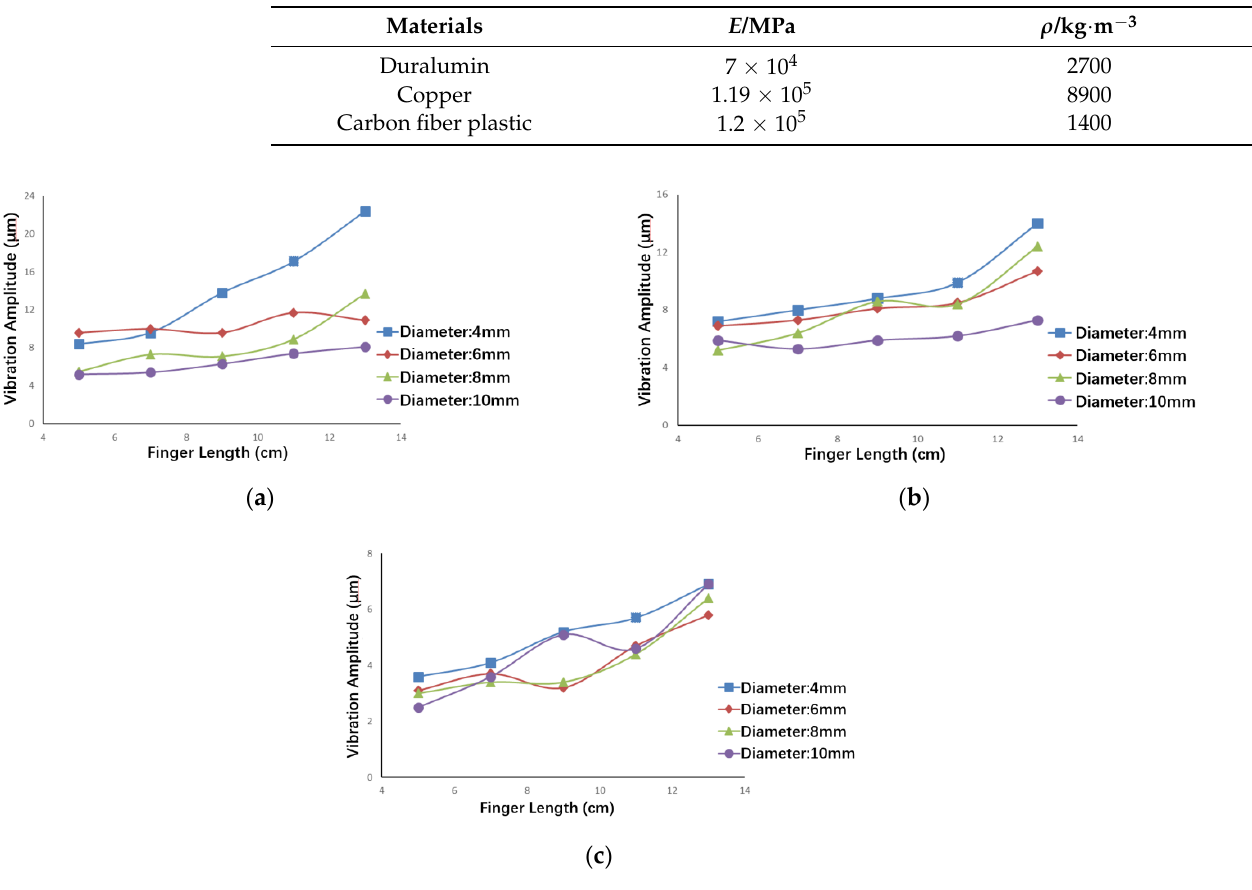
Figure 9. Vibration amplitudes of the fingertips: ( a ) duralumin finger; ( b ) copper finger; ( c ) carbon fiber plastic finger .